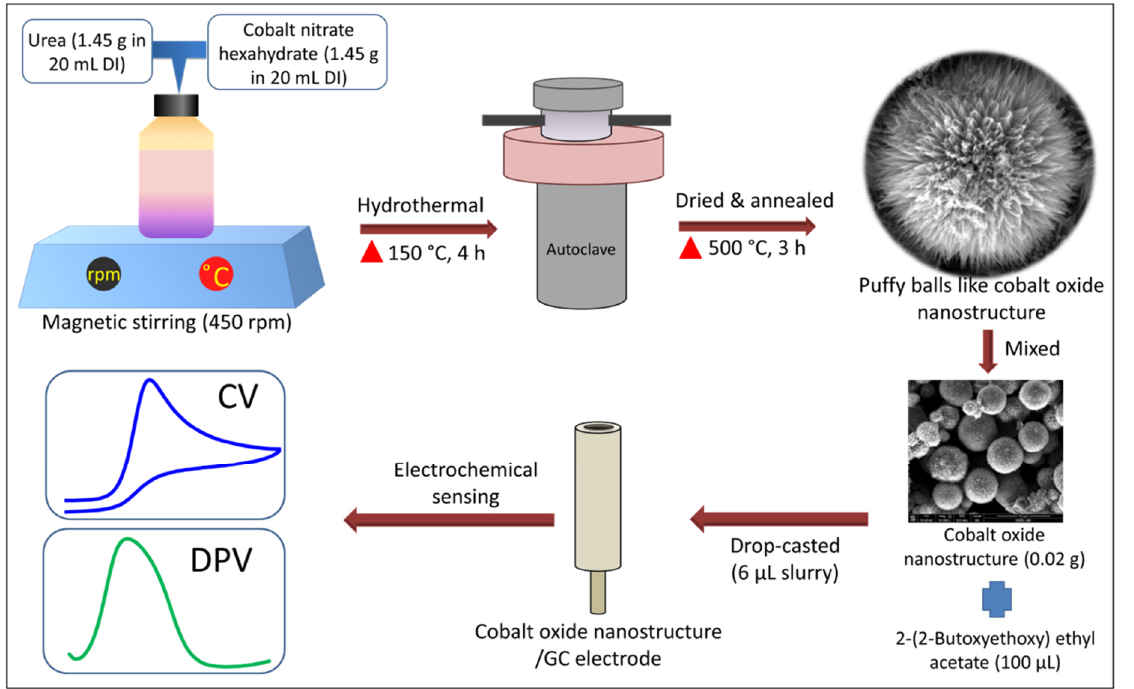
Figure 1. Schematic representation of puffy balls-like cobalt oxide nanostructures synthesis and non-enzymatic electrochemical UA sensor fabrication